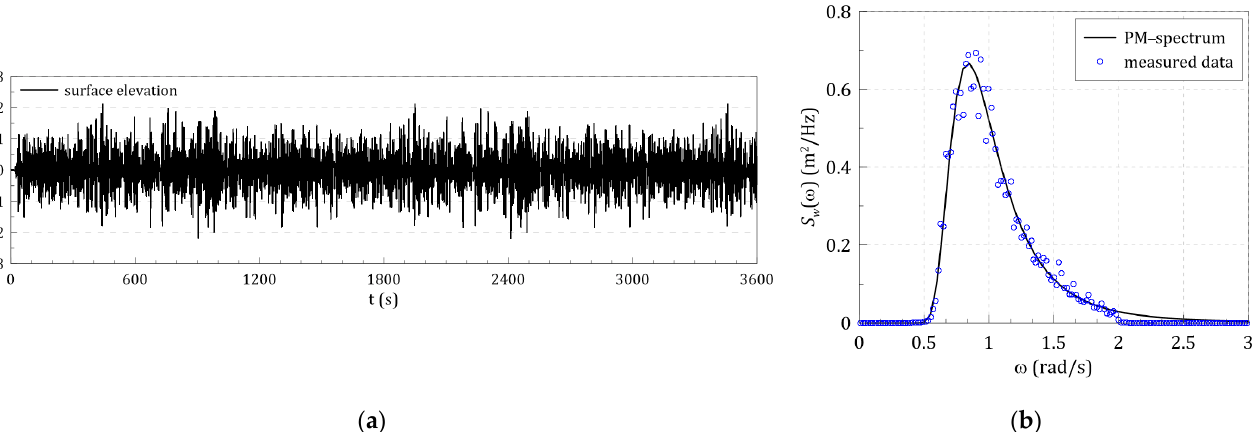
Figure 16. Comparison of target and measured incident irregular waves: ( a ) measured time-series data of irregular waves; ( b ) target theoretical wave spectrum and measured wave spectrum in numerical wave tank, ( 𝐻 (cid:3046) = 2.5 m and 𝑇 (cid:3043) = 7.5 s).